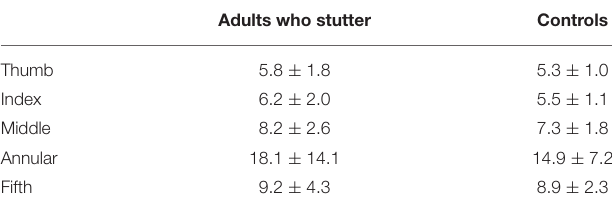
TABLE 1 | Rotation task